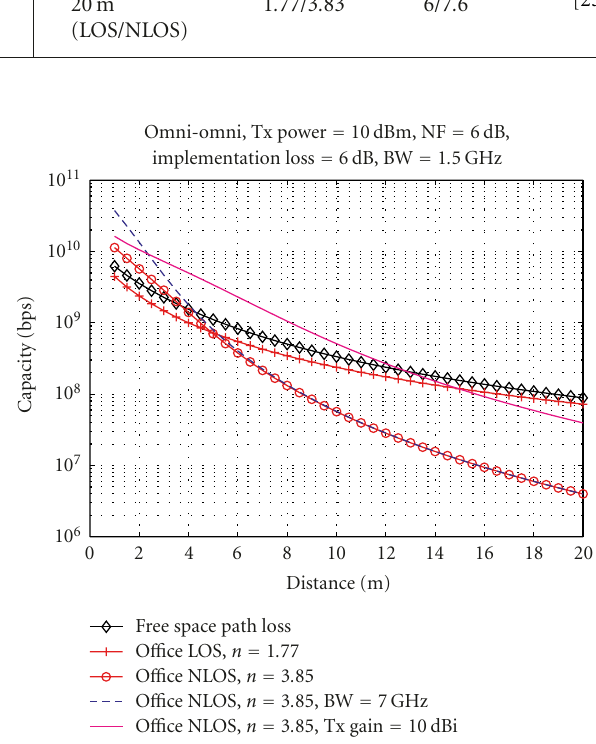
Figure 2: Shannon capacity limits for the case of indoor o ffi ce using omni-omni antenna